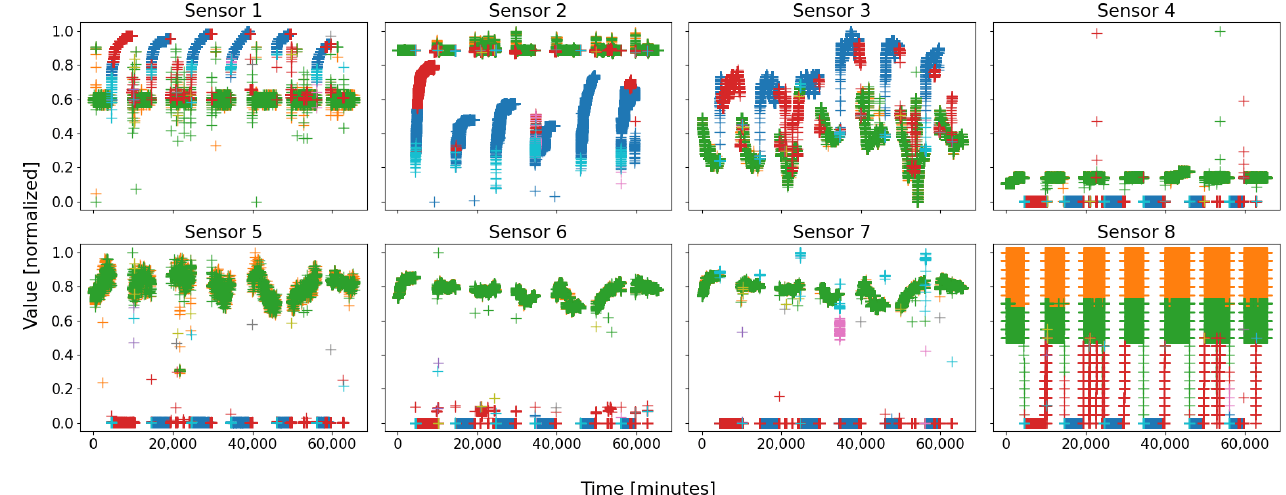
Figure 4. Battery 1’s eight clustered sensors of the rightmost column of Figure